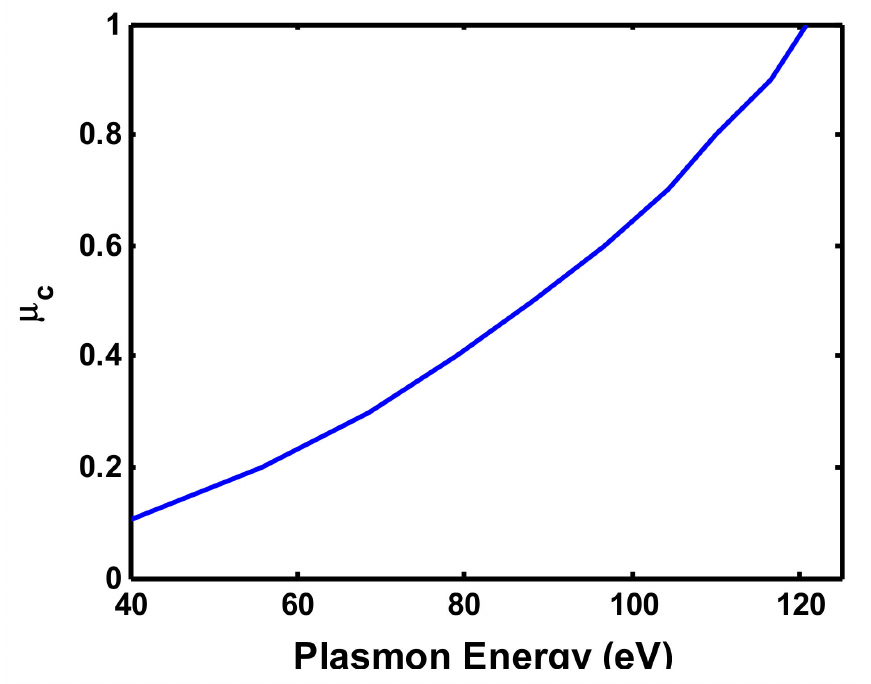
Figure 2. Chemical potential versus input wave energy in graphene.